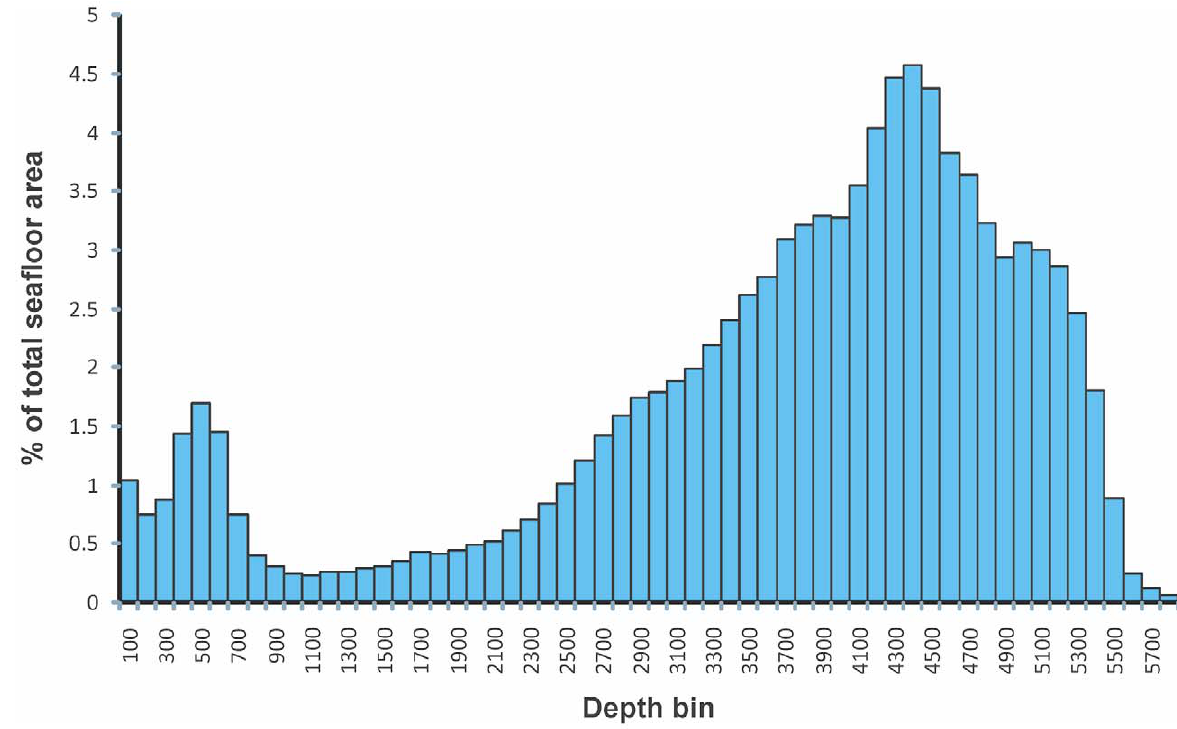
Figure 2. Percentage of Antarctic seafloor area found within 100-m interval depth bins.